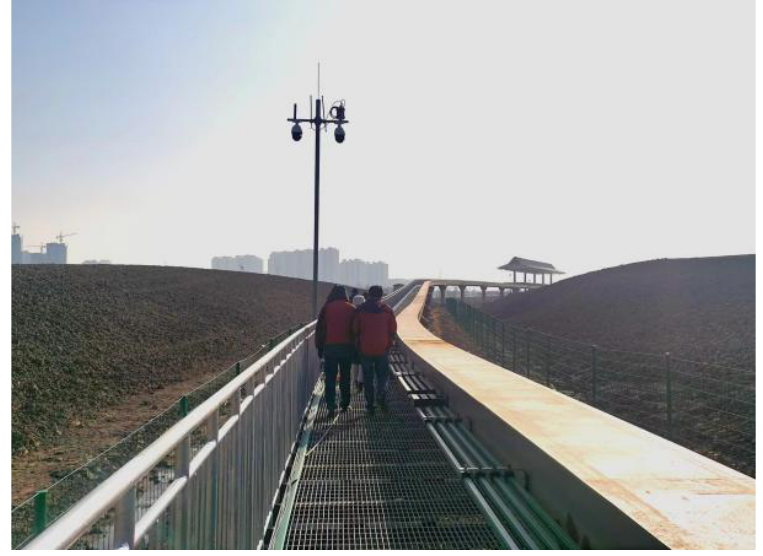
Figure 8. Field test. Table 2. Conditions information.